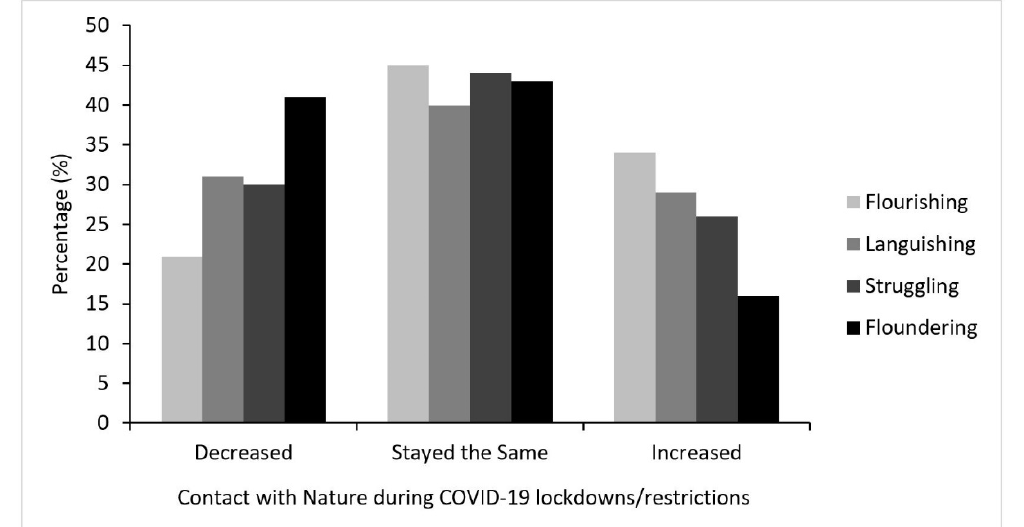
Figure 5. Purposive contact with nature during COVID-19 lockdowns/restrictions by mental health state.